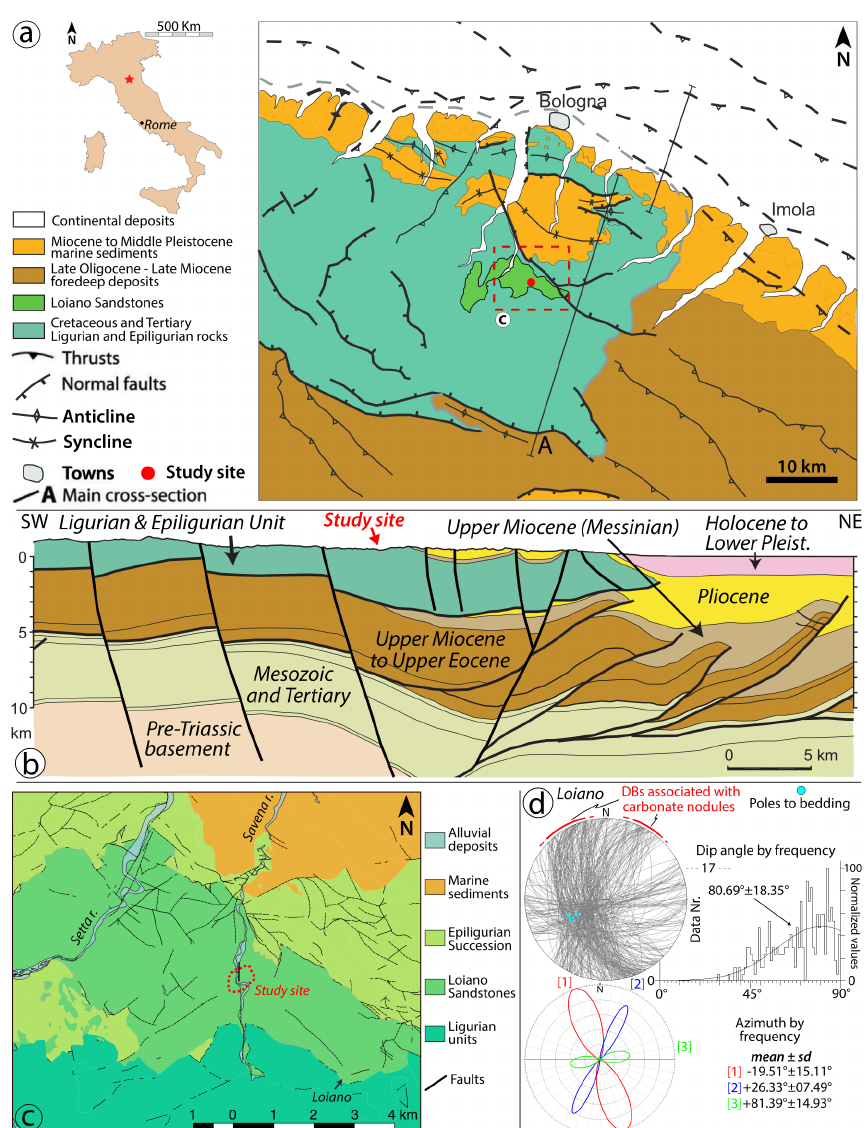
Figure 1. (a) Schematic geologic map and (b) cross section of the northern Apennines near Bologna (Italy), modified from Picotti and Pazzaglia (2008). (c) Geologic map of the study area and location of the studied outcrops (red dotted line). This map is constructed from data on the Regione Emilia–Romagna (http://www.regione.emilia-romagna.it/, last access: 17 December 2019). The location of (c) is indicated by a red square in (a) . (d) Lower-hemisphere equal-area projection indicates the orientation of the different sets of DBs (298 data points) and poles to bedding at the study site. DBs associated with carbonate nodules are highlighted by a red line. DBs azimuth (strike; N ± 90 ◦ ) frequency rose diagram and dip angle ( ◦ ) plotted against frequency. Best-fit Gaussian curves superimposed on the corresponding data histograms (frequency distributions). Gaussian peaks and related standard deviations ( ± SD) are indicated for each